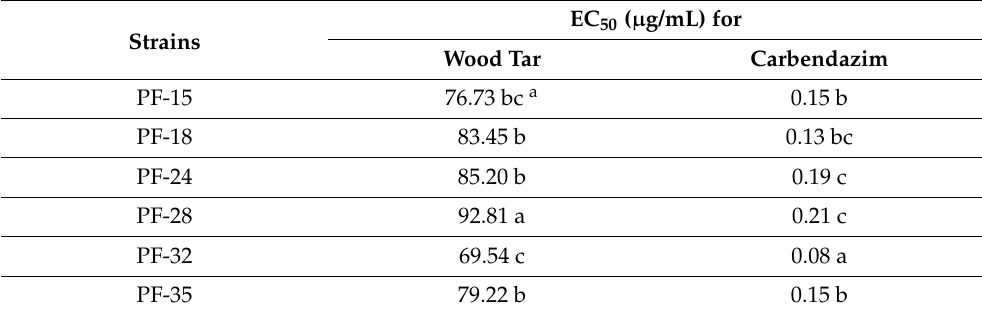
Table 1. The sensitivity of V. mali to wood tar and carbendazim. Strains